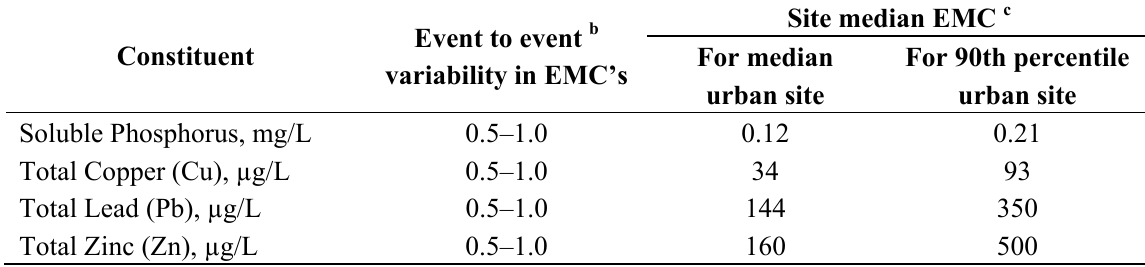
Table 1. Water quality characteristics of urban runoff a .